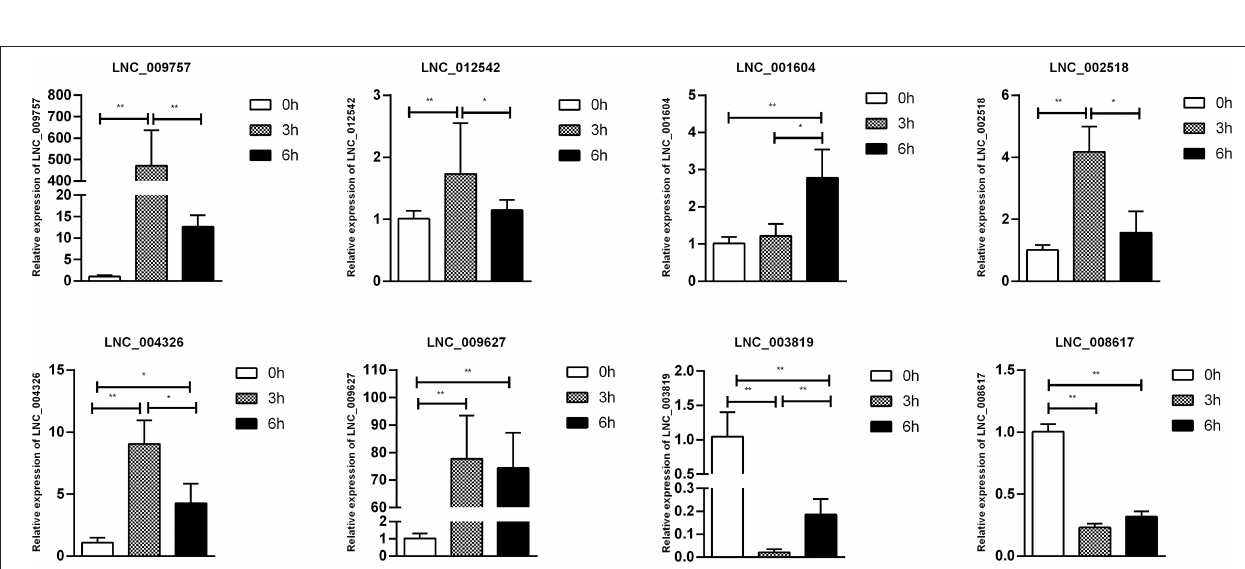
FIGURE 8 | Validation of lncRNA differential expression results during SE infection in duck granulosa cells at 0, 3, and 6 hpi. qRT-PCR validation of LNC_002518, LNC_004326, LNC_009627, LNC_009757, LNC_012542, LNC_003819, and LNC_008617. lncRNA expression levels in cell samples between 0, 3, and 6 hpi. The lncRNA expression levels at 3 and 6 hpi were normalized to the value at 0 hpi. Error bars indicate the mean ± SD of triplicate experiments. β -actin was used as as reference gene. * P < 0.05; ** P <